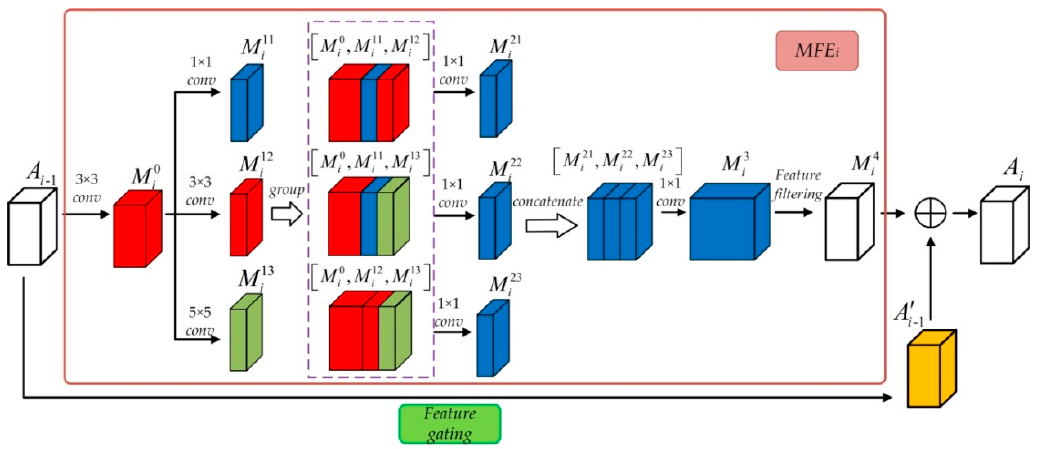
Figure 2. The structure of AMFE module.